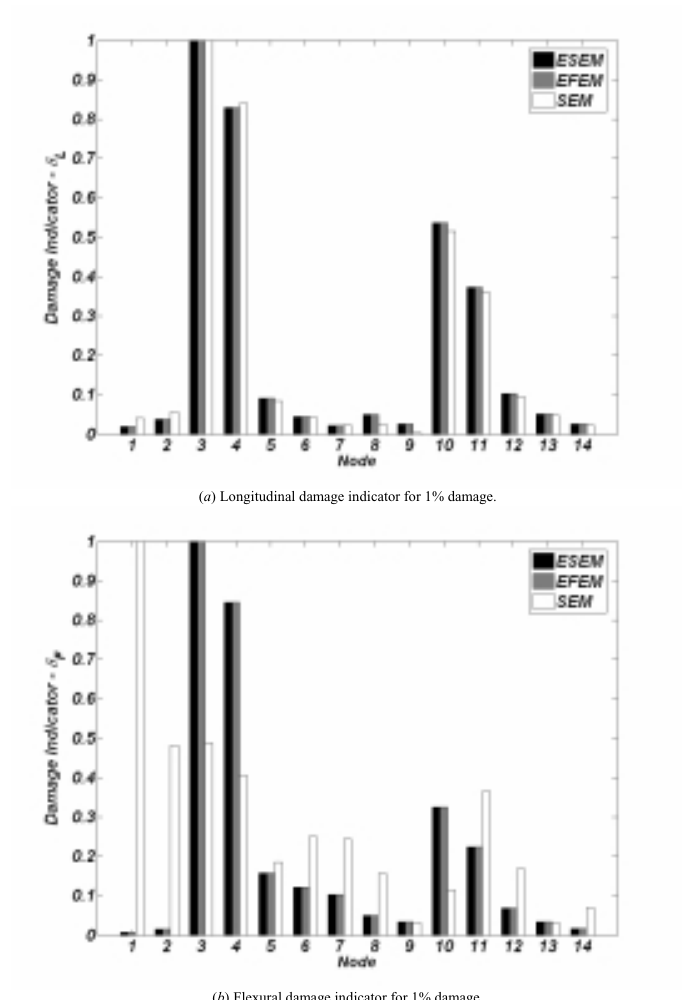
Fig. 9. Longitudinal and flexural damage indicator by ESEM, SEM and EFEM for beams angle connection coupling with damage level of 1% change in the loss